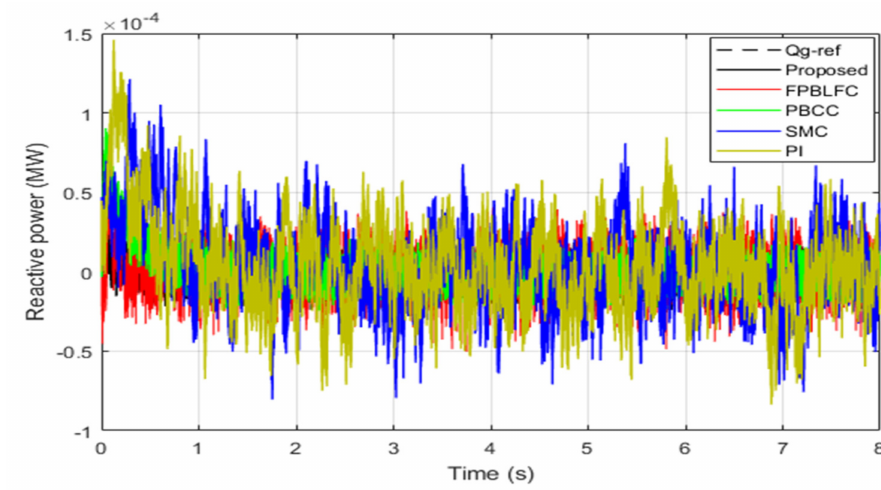
Figure 9. Zoom on DC-link voltages.